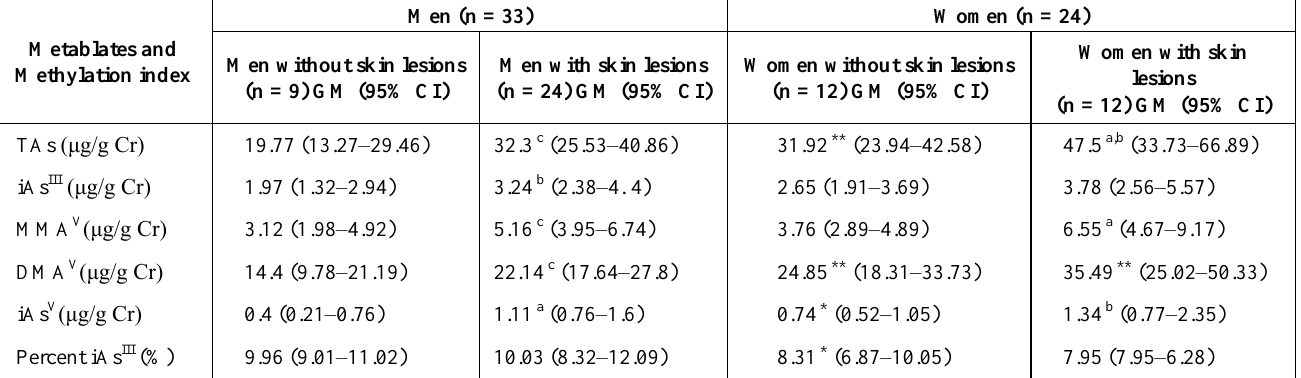
Table 3. Concentrations and percentages of arsenic species in urine of the men and women (N = 57). Metablates